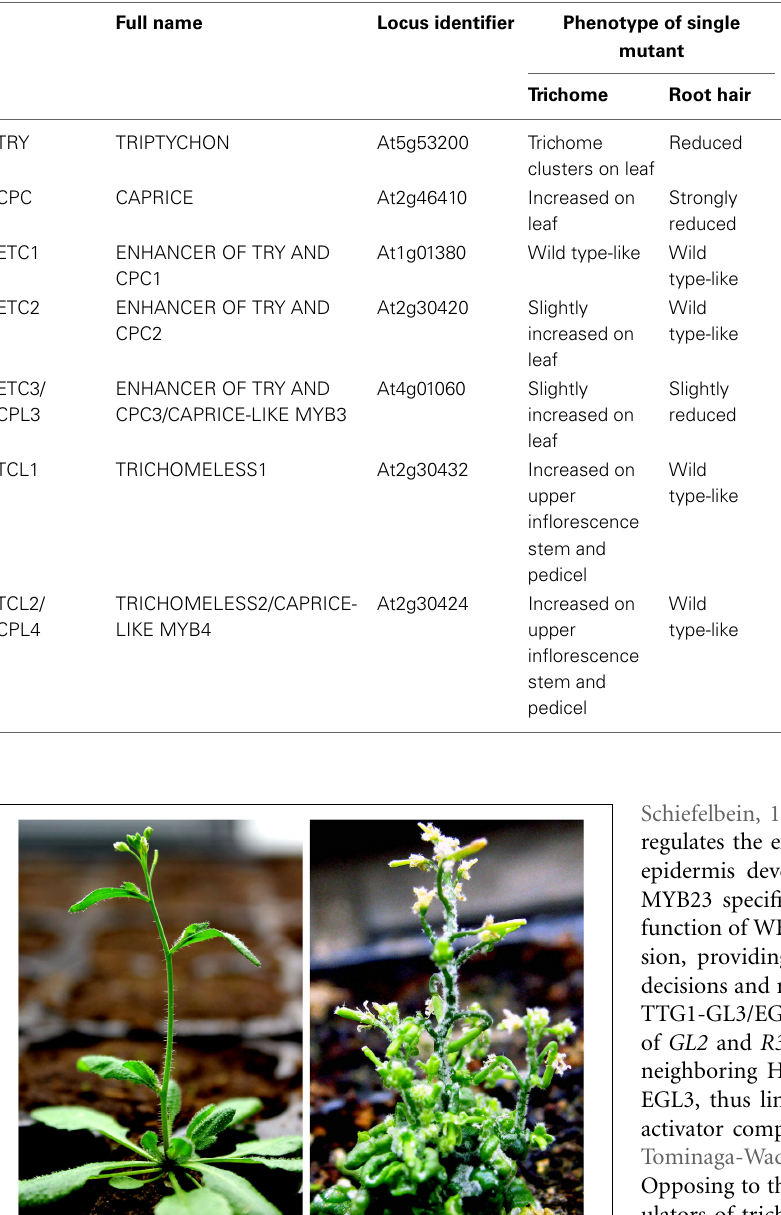
Table 1 | Summary of R3 MYB transcription factors in Arabidopsis.